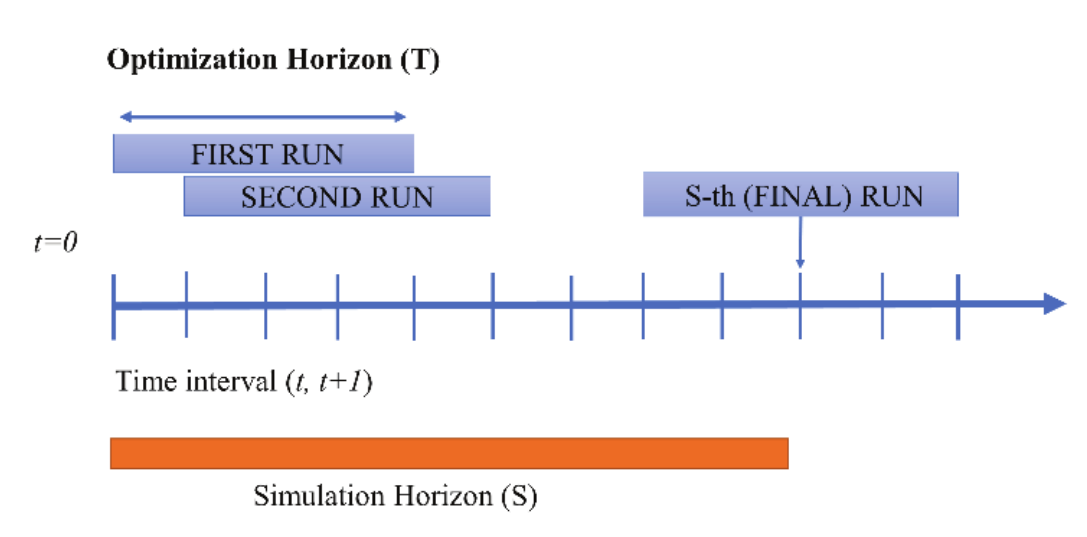
Figure 3. Model predictive control (MPC) scheme.